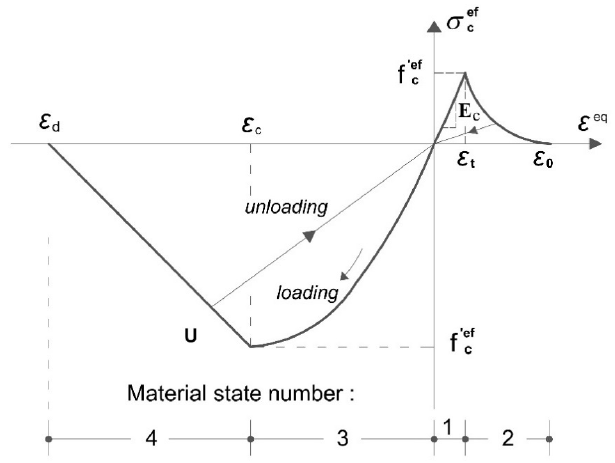
Figure 5. Uniaxial stress-strain relationship for concrete.